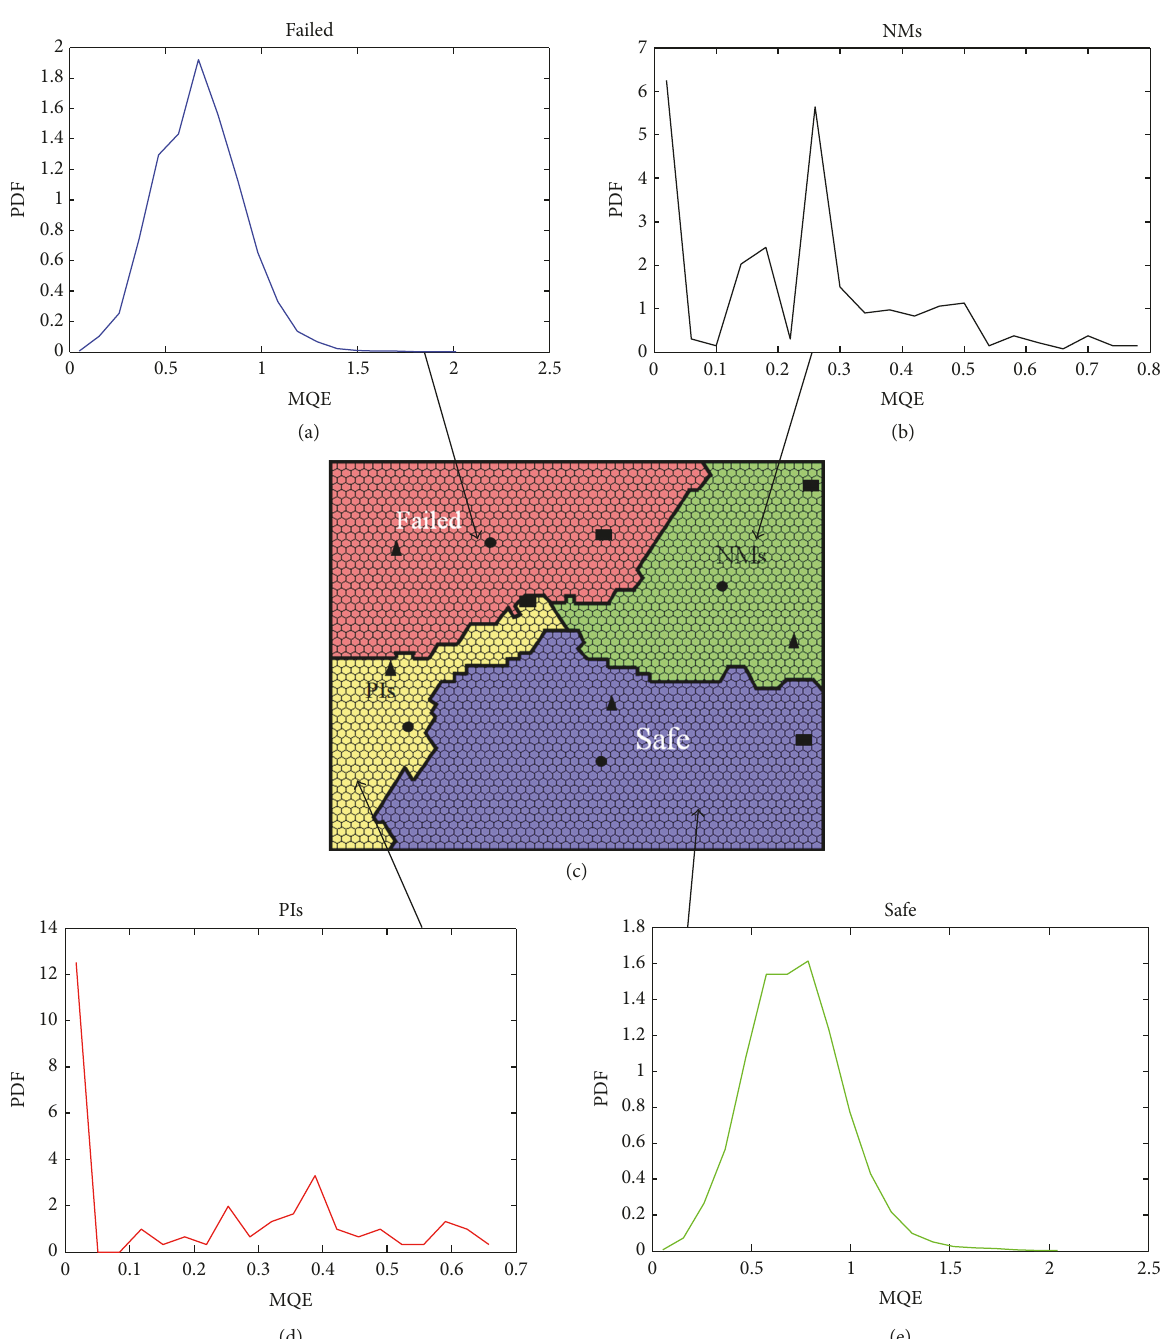
Figure 2: The stand-alone SSSOM (c): different shades of color indicate different classes, circles are the geometric barycenters of the classes, triangles are the minimum neurons of the classes, and rectangles are the maximum neurons of the classes. (a) PDF of the MQE for failed scenarios; (b) PDF of the MQE for NMs scenarios; (d) PDF of the MQE for PIs scenarios; (e) PDF of the MQE for safe